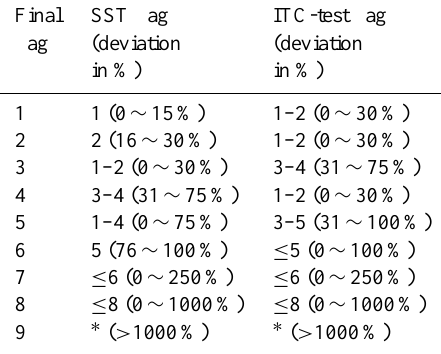
Table 2. Classification scheme and deviations of the data quality for the final flag system, steady state test (SST) and integral turbulence characteristics test (ITC-test) after Foken et al. (2004).